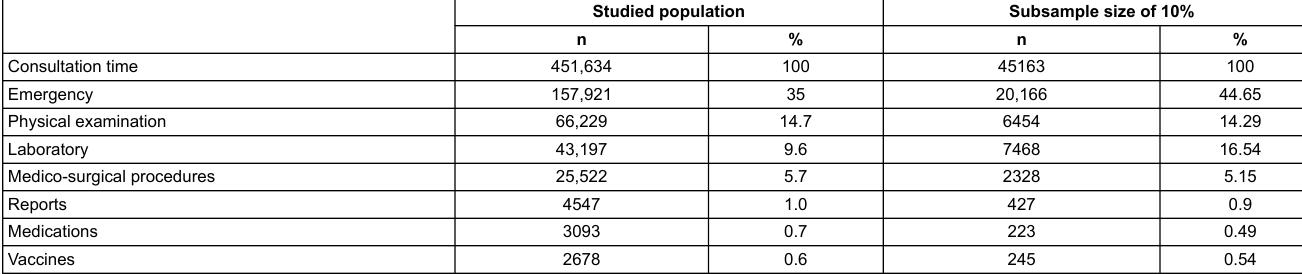
Table S1: Proportion of items billed during home visits and for sub sample size